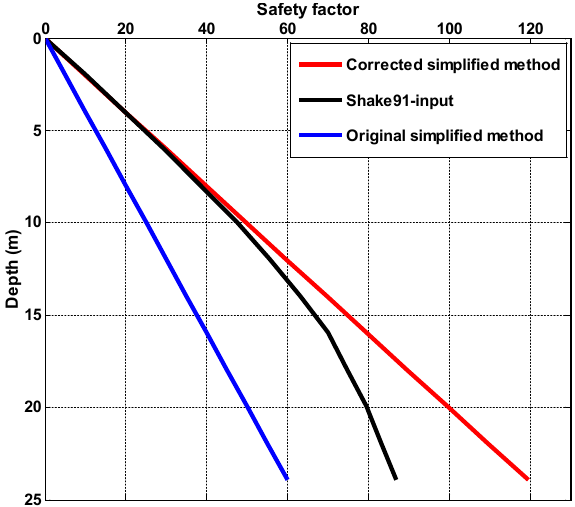
Figure 12: Safety factor according to the depth computed by the original and corrected versions of the simplified method (Coastal roadSkikda site).